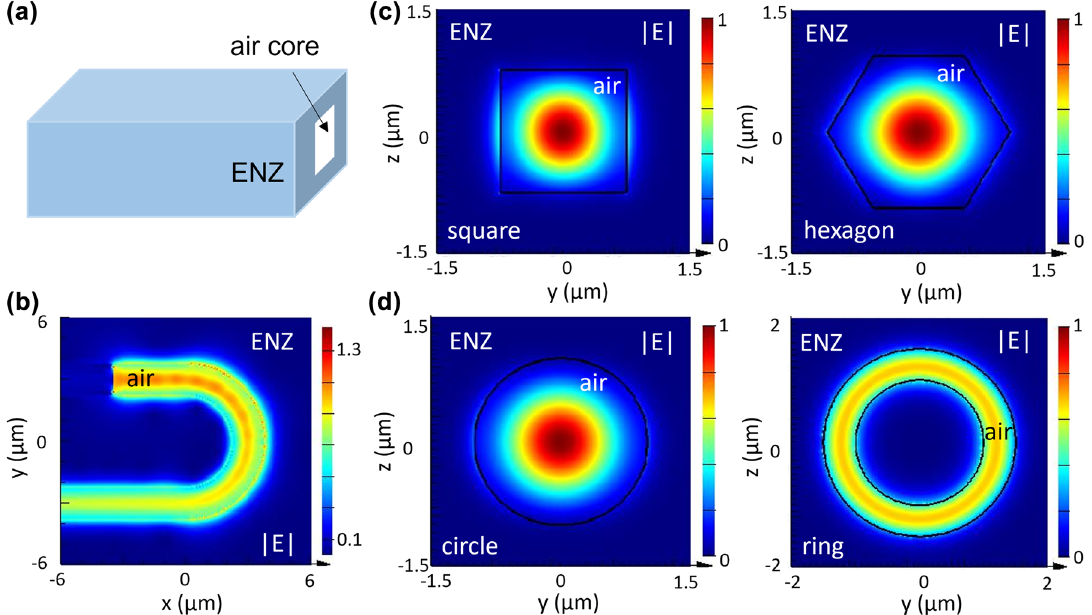
Figure 3: Light propagation within air-core optical waveguides based on ENZ materials. (a) Scheme of a three-dimensional layout. (b) The light propagation with a curved air-core waveguide (side length w = 1.5 μ m, radius R = 3 μ m) embedded in the ENZ material under TE polarization. (c) Mode confinement in a zero-index environment with a square or a hexagonal waveguide cross section. (d) Mode confinement in a zero-index environment with a circular or a ring-shaped cross section. The mode profiles were plotted under TE polarization. The plotting wavelength is 𝜆 = 1.3 μ